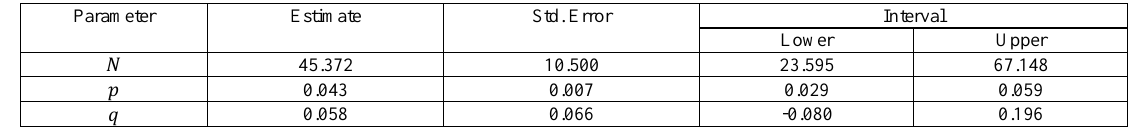
Table 1. Parameter estimation